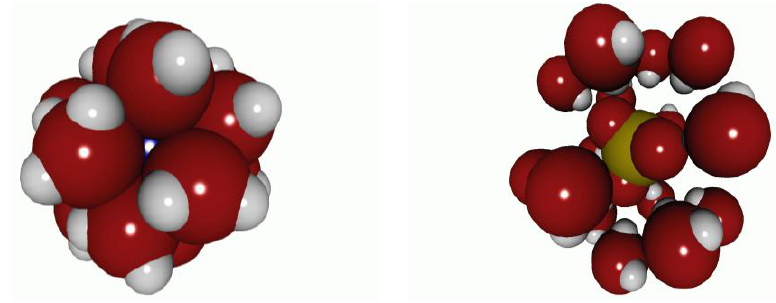
Figure 1. Initial structure with 16 H 2 O for the Mg 2+ cation on the left, and the SO 42− anion on the